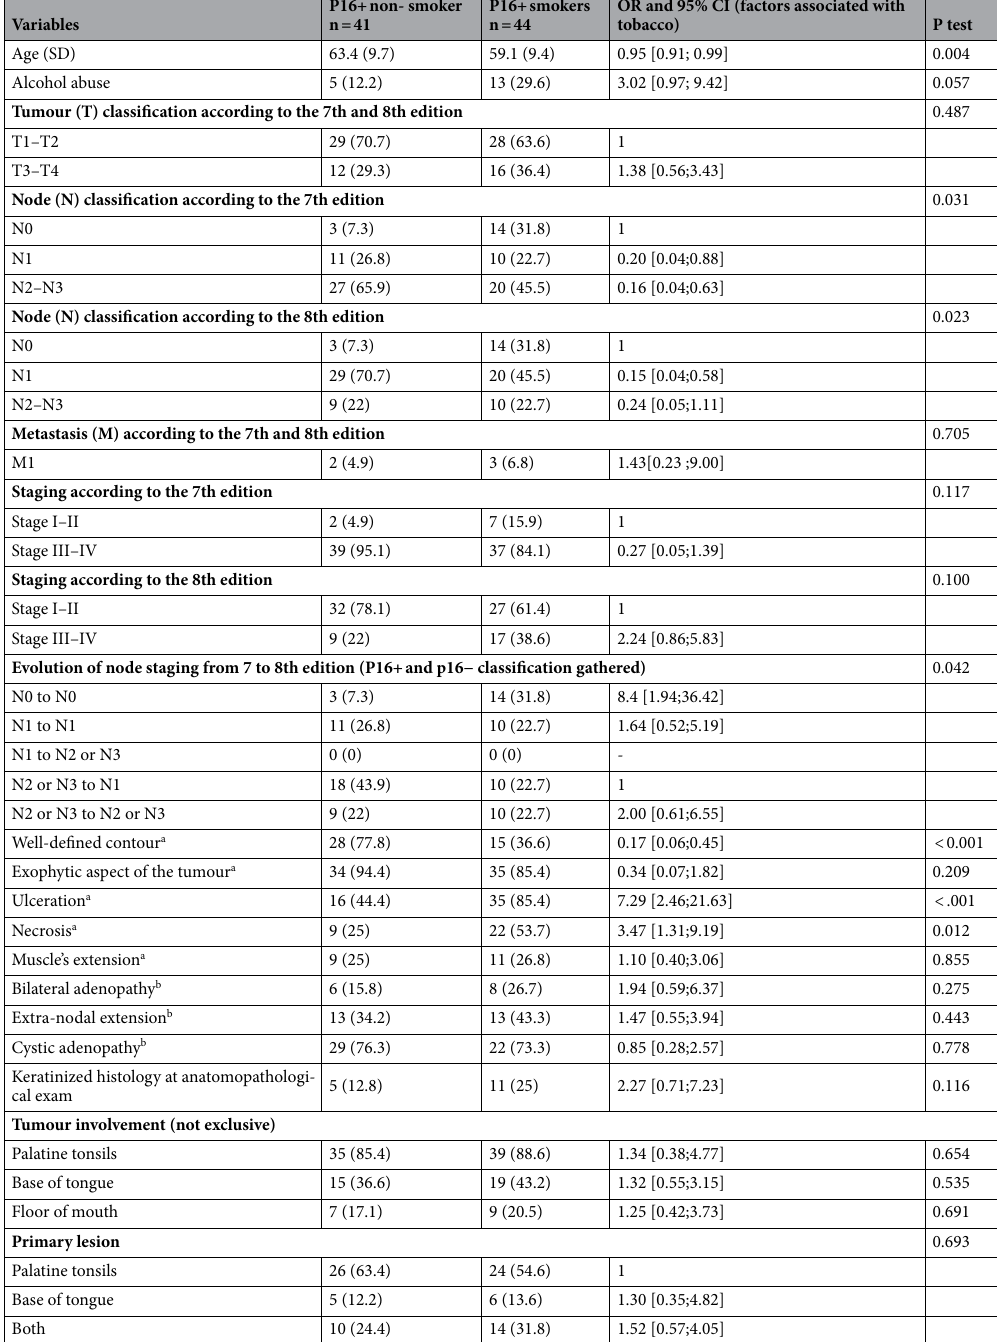
Table 3. Comparison of data from P16+ non-smokers and P16+ smokers (n = 85). Variables are displayed as number (%) or mean (standard deviation). a Data are missing for 8 patients owing to no visible tumour (not visible clinically or on CT; pT1 on anatomopathological exam). b Data missing for 17 patients owing to no visible adenopathy